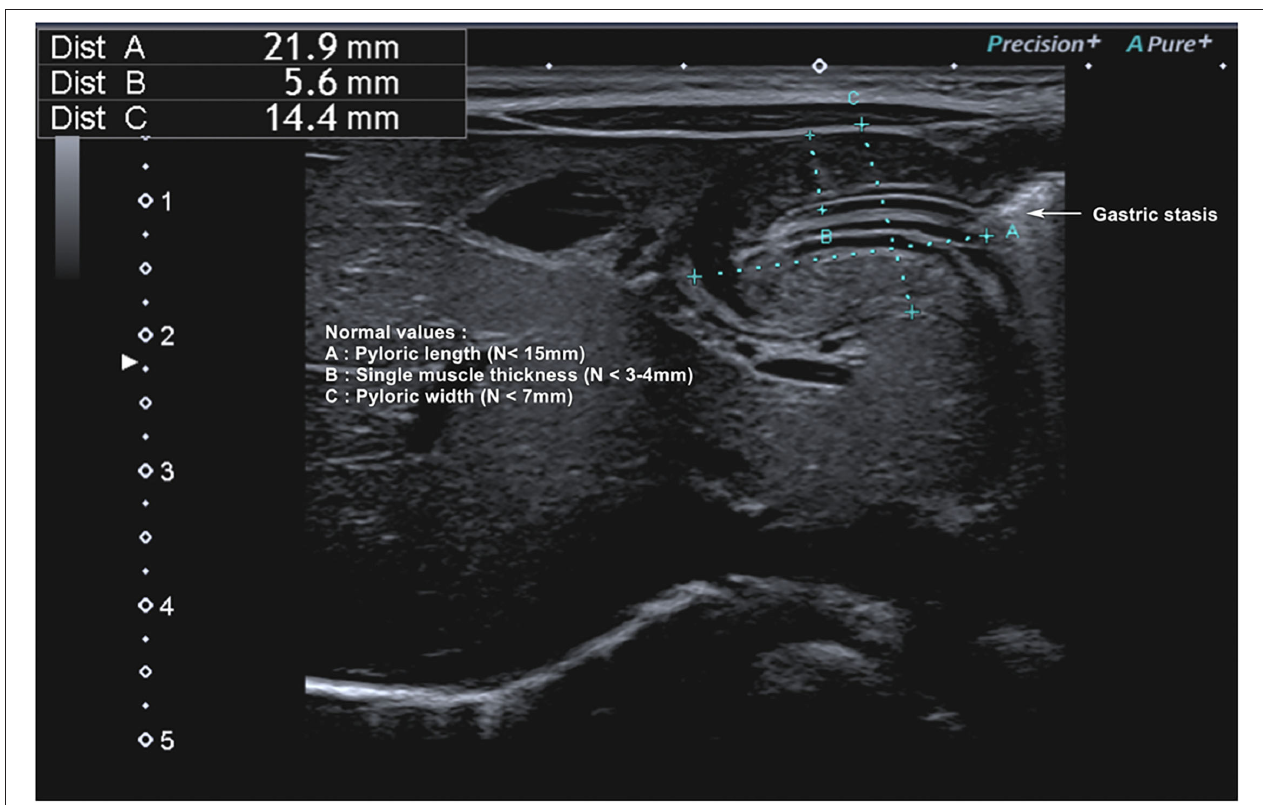
FIGURE 6 | Hypertrophic pyloric stenosis. Gastric POCUS consisted of the measurements of pylorus muscle thickness and length, and HPS diagnosis was confirmed if they were > 3 and 15mm, respectively. A 6–10 MHz linear probe in a transverse position allows identifying the gallbladder in the supine position. The pylorus is usually located slightly medial and posterior in relation to the